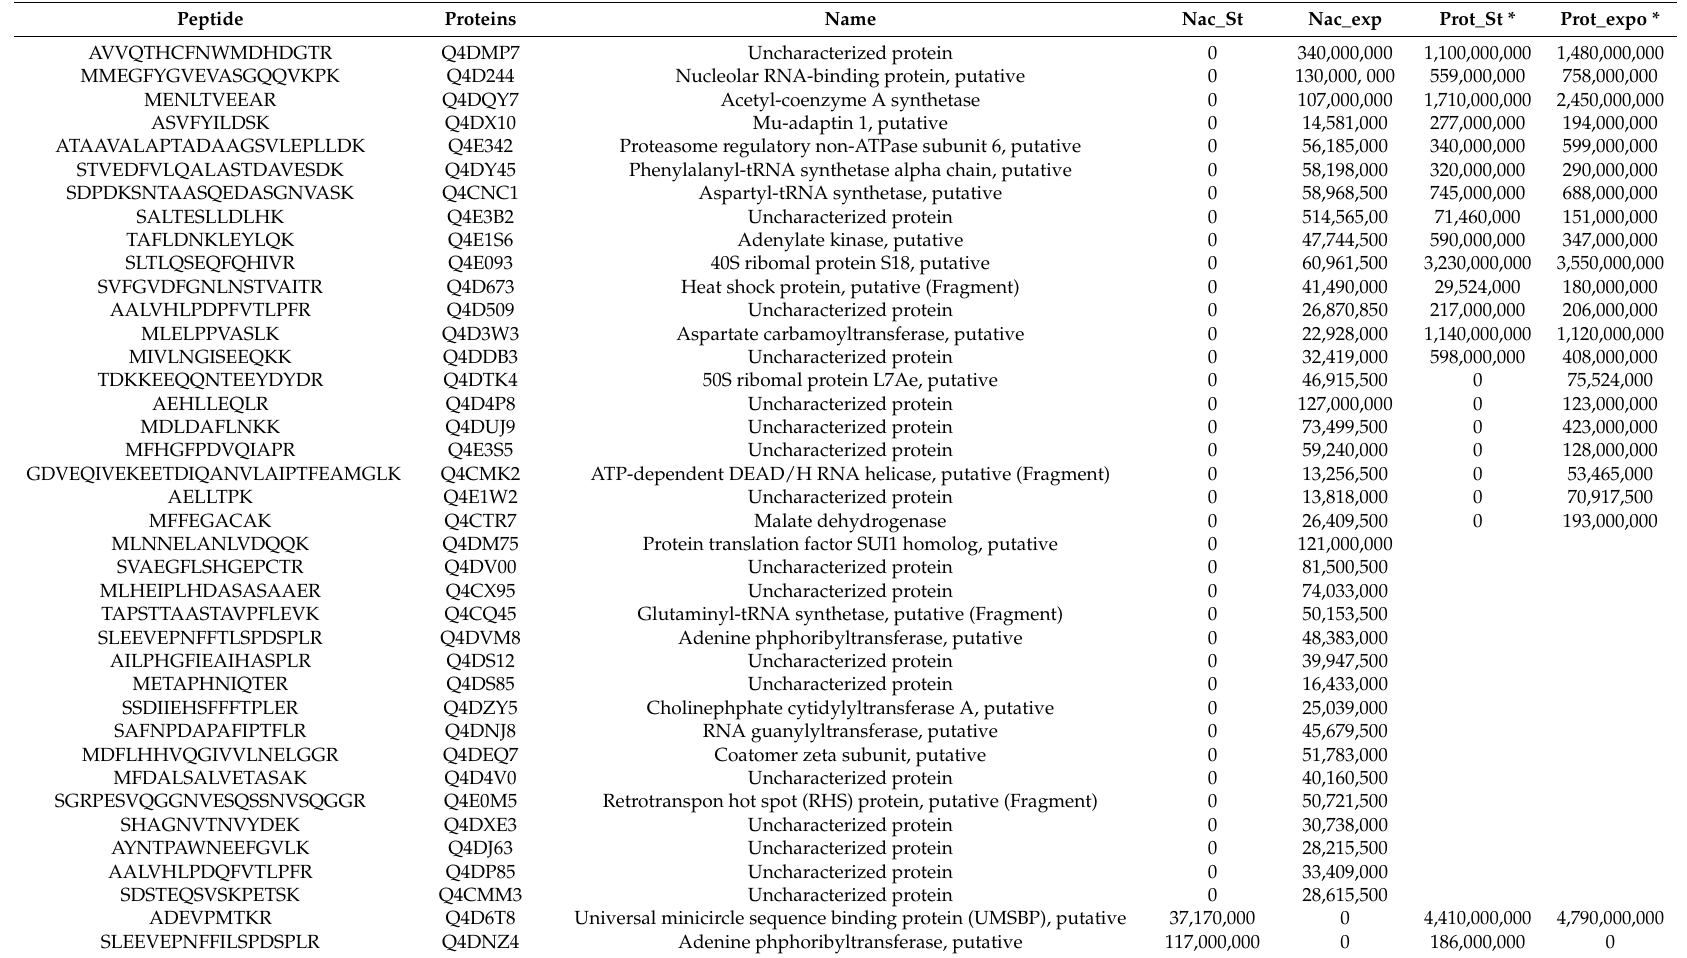
Table 2. T. cruzi N-terminal acetylated peptides detected in one condition. Peptide sequences are reported. Nac_St and Nac_expo indicate the acetylated peptides in the stationary and exponential phase, respectively. Prot_St and Prot_expo indicate the average protein expression in the stationary and exponential phase. * Proteins quantified in two biological replicates in at least one condition were